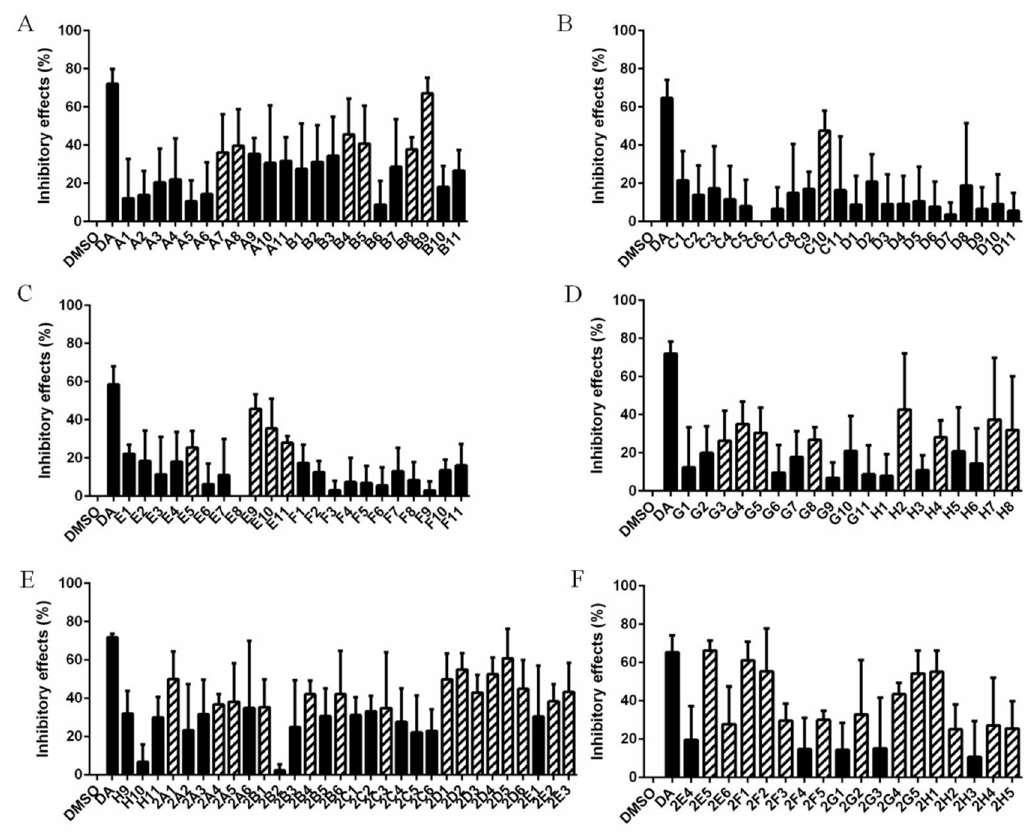
Figure 2. The calculated inhibitory effects of 133 natural products on B. microti . The error bars indicate standard error of the means for each tested group. The hollow cylinders indicate the natural products with significant difference from DMSO that were subsequently used for rescreening. ( A ) The natural products from A1 to B11. ( B ) The natural products from C1 to D11. ( C ) The natural products from E1 to F11. ( D ) The natural products from G1 to H8. ( E ) The natural products from H9 to 2E3. ( F ) The natural products from 2E4 to 2H5.